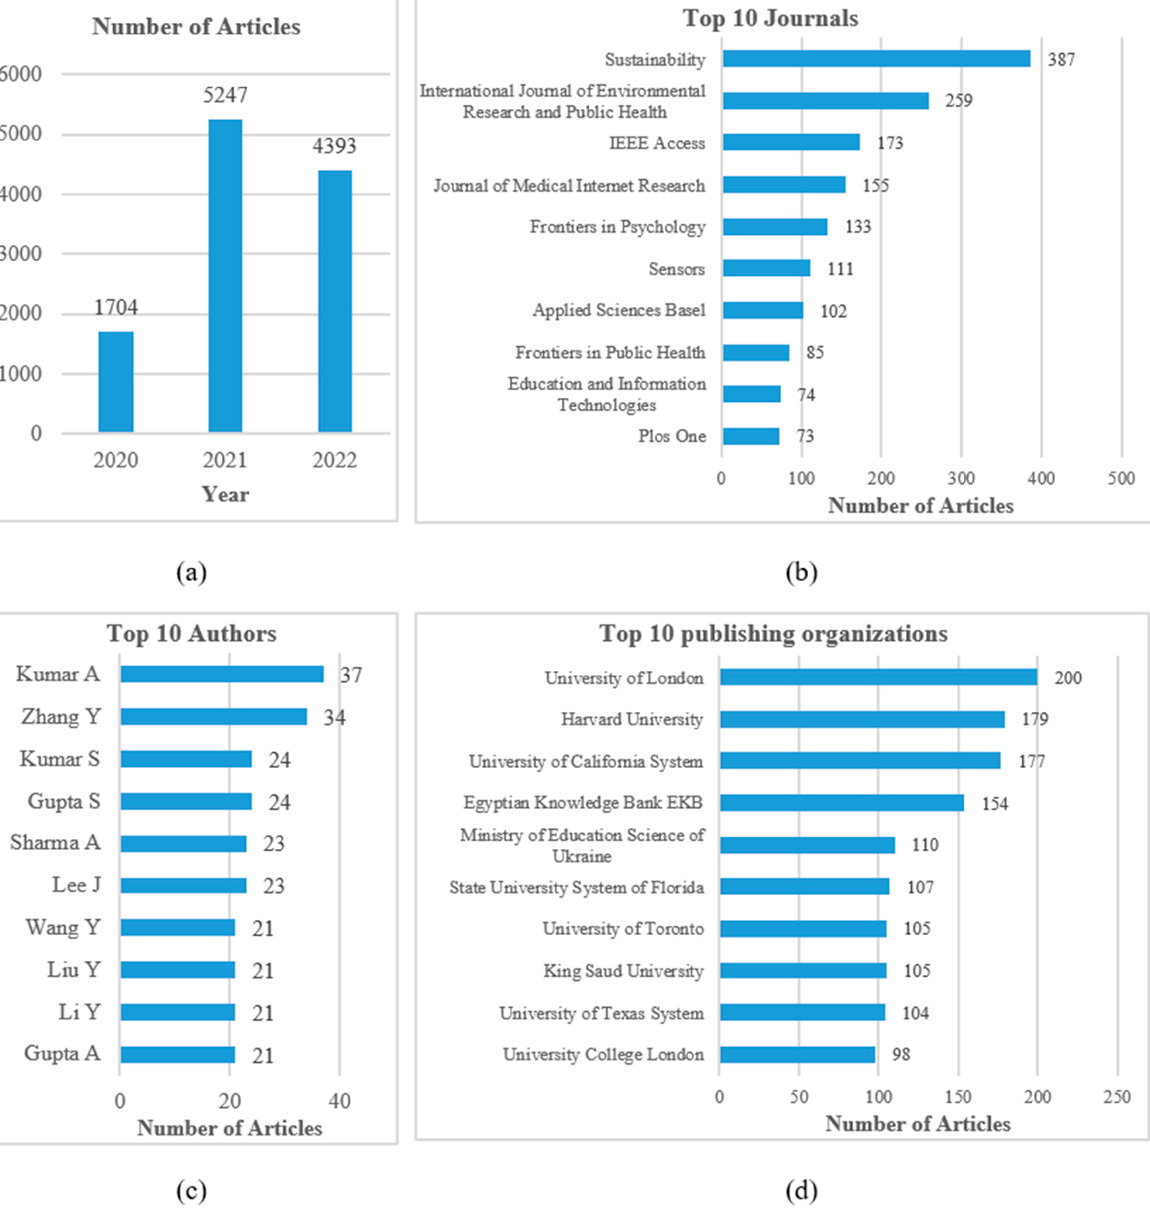
Figure 1. Literature distribution in four basic dimensions: ( a ) the article quantities by year; ( b ) the top 10 journals; ( c ) the top 10 authors; ( d ) the top 10 publishing organizations.